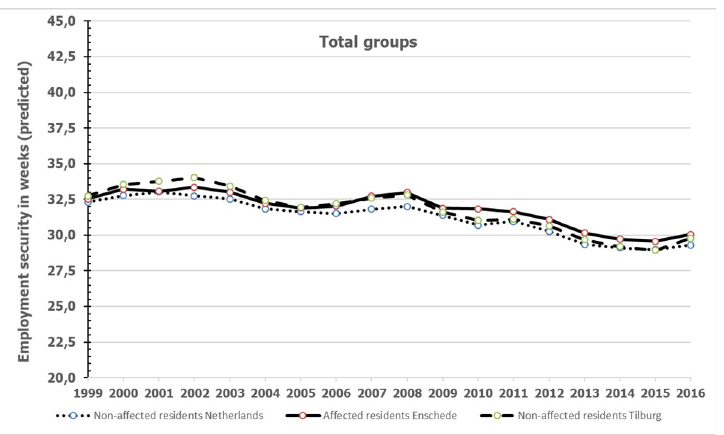
Fig 3. Annual employment security of the total group of affected residents and non-affected control groups.